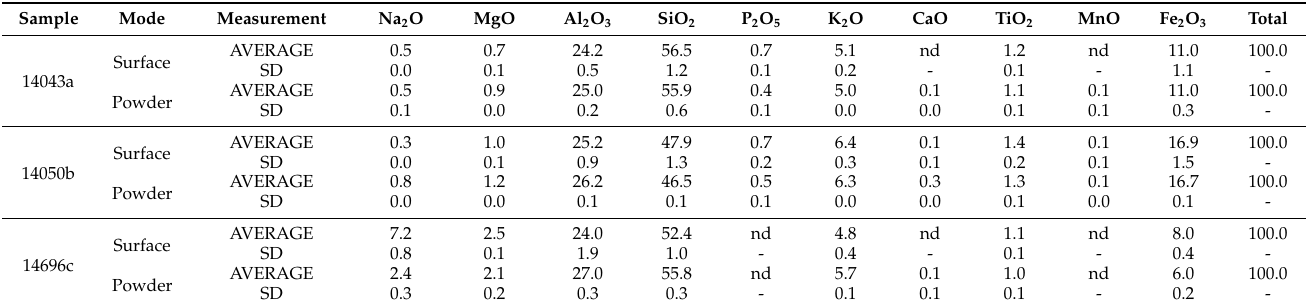
Table 7. Comparison by EDXS between non-invasive analyses on cohesive pieces (surface) and invasive analyses on powder pellets (powder) for geological samples. Results were normalized to 100% by using a conventional list of elements (ICP-OES data). Legend—SD: standard